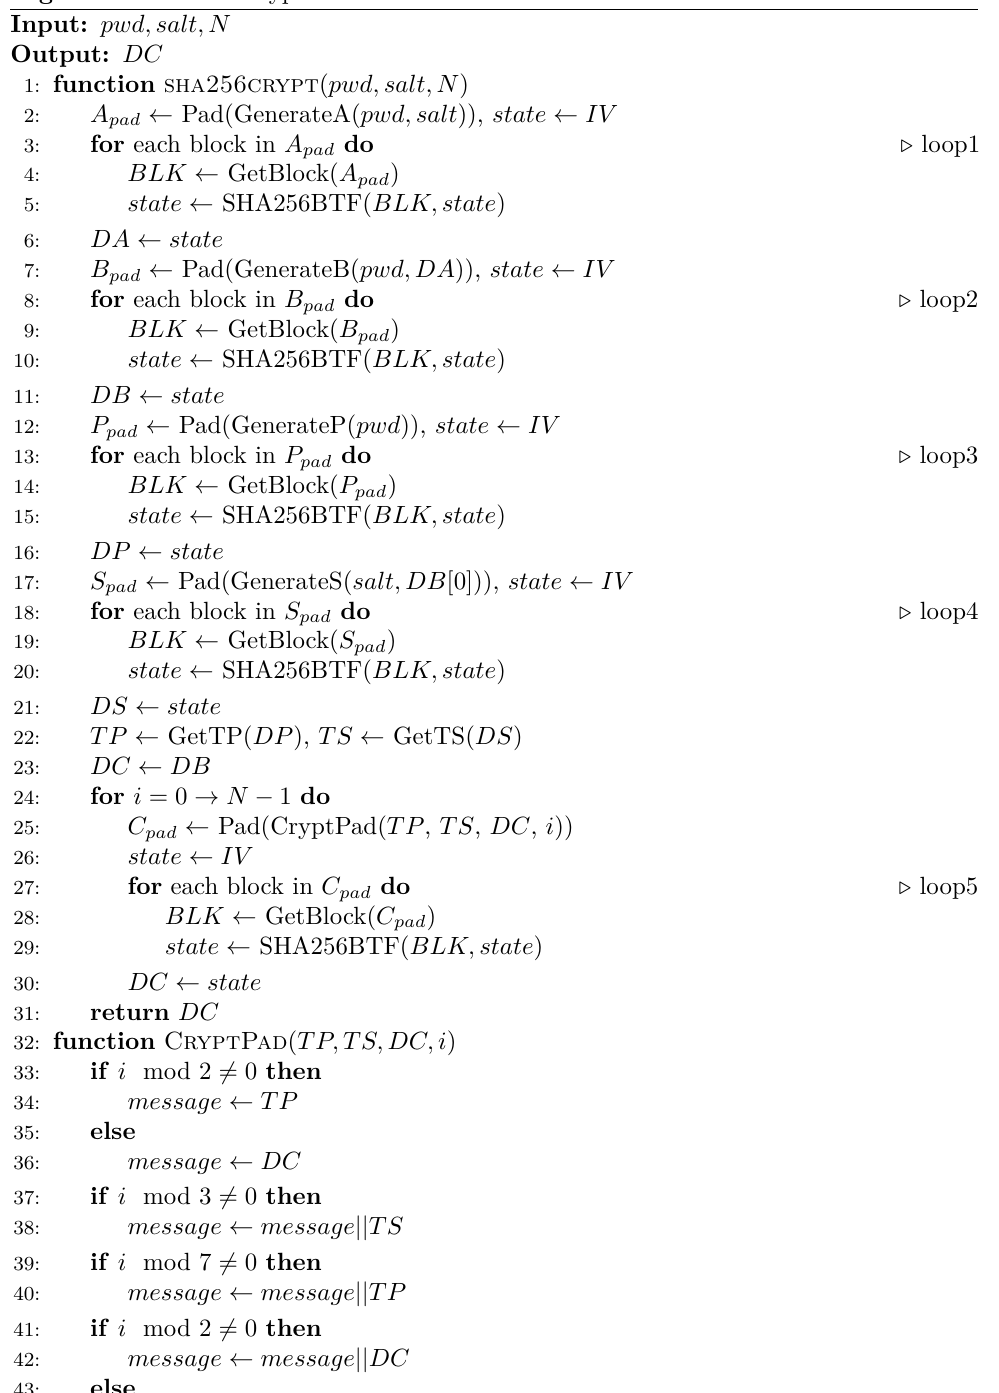
Algorithm 1 Sha256crypt in the brute-force attack